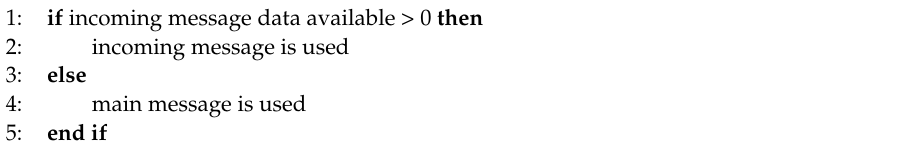
Algorithm 6 Solution: Exceeding the communication